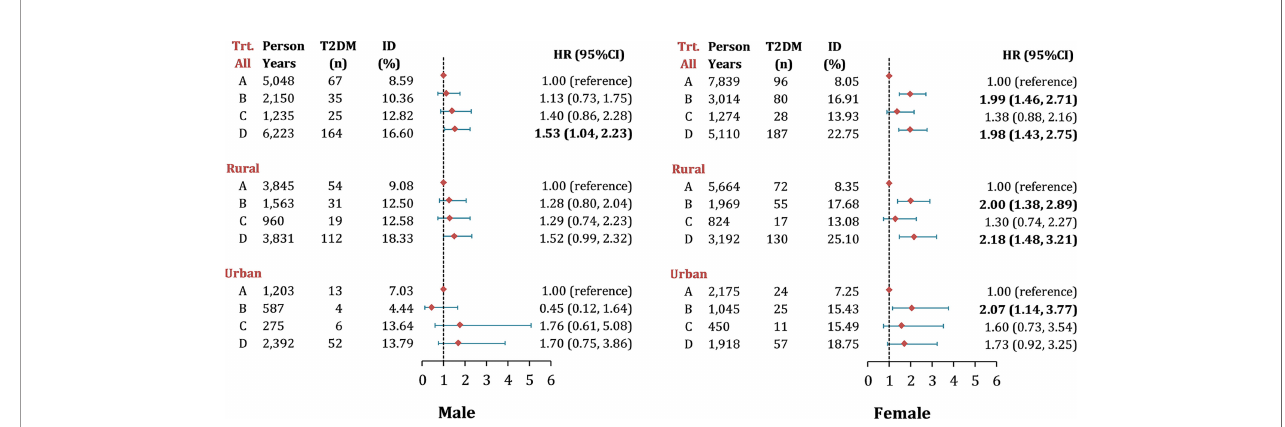
FIGURE 3 | Risk of new-onset T2DM by different LAP transitions in middle-aged and older Chinese. Note: Data were presented as n (%) and hazard ratios (95% CI), adjusted for age, education, region, hypertension, smoking, drinking, general obesity, TC, LDL-c level and HDL-c level; Hazard ratios for T2DM by LAP transitions were calculated using multivariable Cox frailty models with random effect, by which means clustering of participants was accounted for; P< 0.05 were highlighted in bold. ID, incidence density; LAP, lipid accumulation product; Trt., transition types during follow-up, the de fi nition from group A to D were listed as following: Group A, maintain Low LAP during follow-up; Group B, Low LAP at baseline turned to High LAP at follow-up; Group C, High LAP at baseline turned to Low LAP at follow-up; Group D, maintain High LAP during